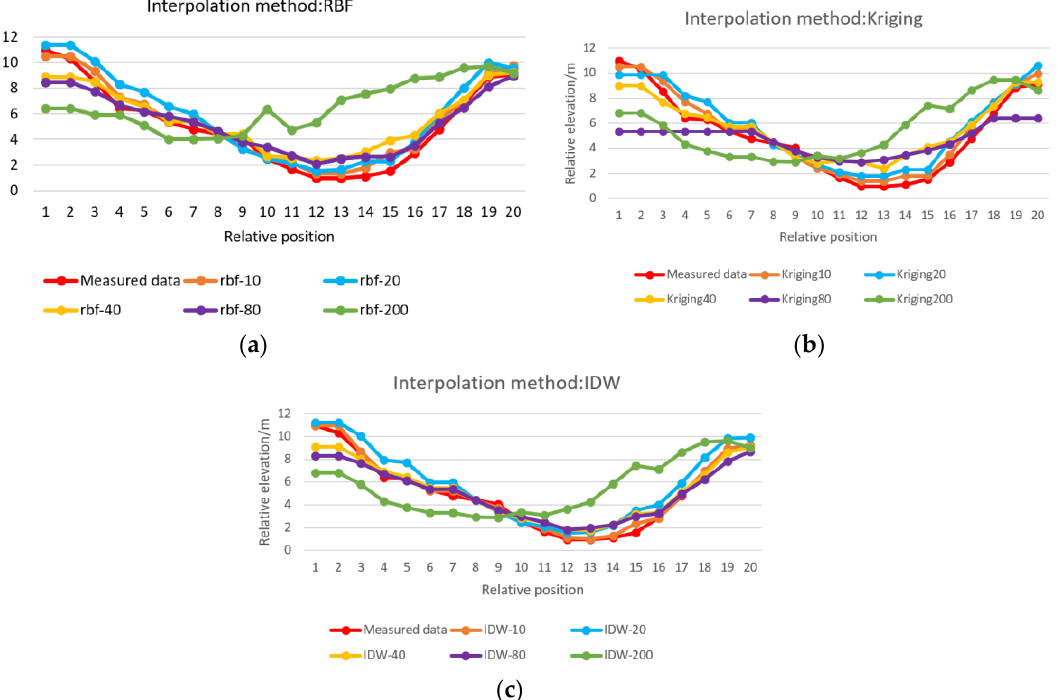
Figure 11. Comparison of interpolation results using the same method with different intervals: ( a ) RBF; ( b ) Kriging; ( c ) IDW.